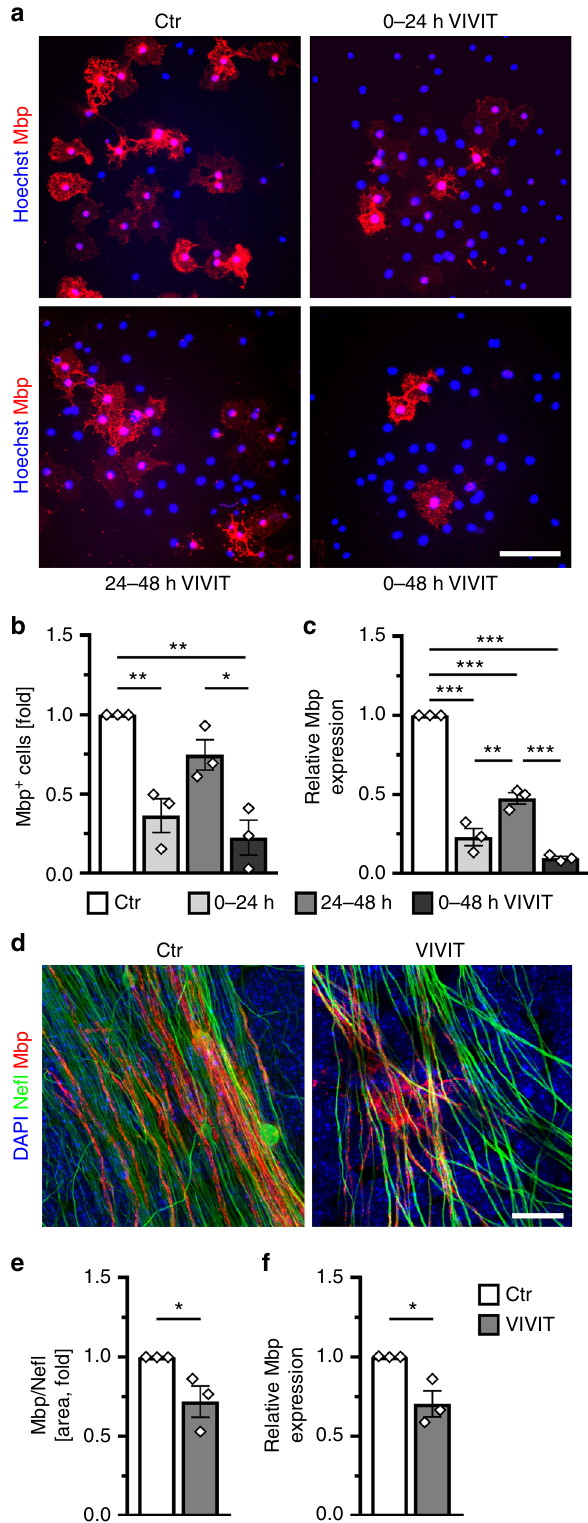
Fig. 1 Nfat/calcineurin signaling is required for oligodendroglial differentiation in culture. a – c Analysis of myelin gene expression in primary mouse oligodendroglial cells cultured for 48 h under differentiating conditions in the absence (Ctr, open bar) or presence of 1 µ M VIVIT (VIVIT, grey bars). Incubation with VIVIT was restricted to the fi rst 24 h (light grey bars) or second 24 h (grey bars) of incubation or throughout the whole cultivation period (dark grey bars). Cultures were stained with antibodies directed against Mbp (red) and counterstained with Hoechst (blue). Scale bar, 50 µ m ( a ). From immunocytochemical stainings the fraction of Mbp- positive cells was determined ( b ) ( n = 3). The relative number of Mbp- positive cells present under control conditions was arbitrarily set to 1 and used to normalize in pairwise fashion (values: 1 for control conditions, 0.37 ± 0.11 for VIVIT treatment during the fi rst 24 h, 0.75 ± 0.09 for VIVIT treatment during the second 24 h, 0.23 ± 0.11 for 48 h VIVIT treatment). RNA from these cultures was also used to perform qrtPCR and determine Mbp levels ( c ) ( n = 3). The amount of Mbp transcripts present after 48 h under control conditions was arbitrarily set to 1 and used to normalize (values: 1 for control conditions, 0.23 ± 0.10 for VIVIT treatment during the fi rst 24 h, 0.48 ± 0.06 for VIVIT treatment during the second 24 h, 0.10 ± 0.02 for 48 h VIVIT treatment). d – f Analysis of myelination in cerebellar slices of newborn mice after 12 days of culture in the absence (Ctr, open bars) and presence (VIVIT, grey bars) of 1 µ M VIVIT ( n = 3). Cultures were stained ( d ) with antibodies directed against Mbp (red) and Neuro fi lament L (Ne fl , green) and counterstained with DAPI (blue). Scale bar, 20 µ m. The extent of myelination was assessed by determining the Ne fl -positive area co-stained with Mbp ( e ). The Mbp/Ne fl ratio under control conditions was arbitrarily set to 1 and used to normalize in pairwise fashion (values: 1 for control conditions, 0.72 ± 0.09 for VIVIT treatment). RNA prepared from these cultures was used to determine Mbp and Ne fl expression ( f ). The amount of Mbp relative to Ne fl transcripts under control conditions was arbitrarily set to 1 (values: 1 for control conditions, 0.71 ± 0.08 for VIVIT treatment). Statistical signi fi cance was determined by Bonferroni-corrected one-way ANOVA in ( b ) and ( c ) and two-tailed Student ’ s t -test in ( e ) and ( f ) (* P ≤ 0.05; ** P ≤ 0.01; *** P ≤